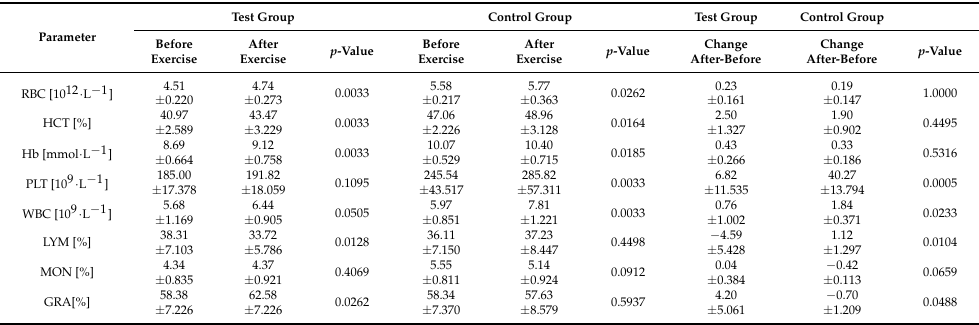
Table 4. Basic characteristics and changeability of hematological parameters measured before and after the exercise in both